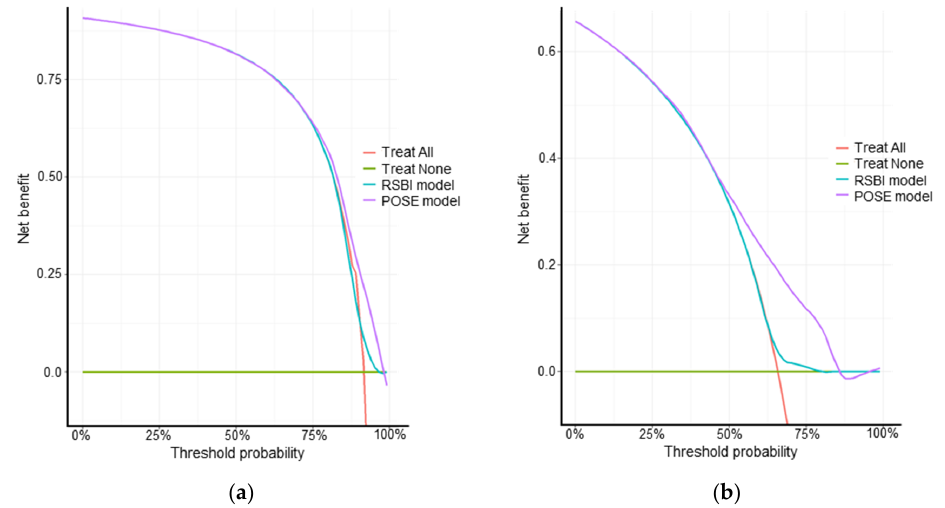
Figure 4. Predictive probabilities for successful extubation ( a ) and uneventful extubation ( b ). The inter-model differences between the novel prediction model based on eight predefined physiological factors (POSE model) and the conventional prediction model comprising RSBI alone (RSBI model) are demonstrated using NRI and IDI. Event indicates successful extubation ( a ) and uneventful extubation ( b ). The dashed line indicates the coincidence between the predicted probabilities of the POSE model (vertical axis) and the RSBI model (horizontal axis). The majority of patients with events fell above the dashed line, demonstrating that the POSE model predicts a higher probability of event occurrence than the RSBI model. POSE, Prediction of Successful Extubation; RSBI, rapid shallow breathing index; NRI, Net Reclassification Improvement; IDI, Integrated Discrimination Improvement.